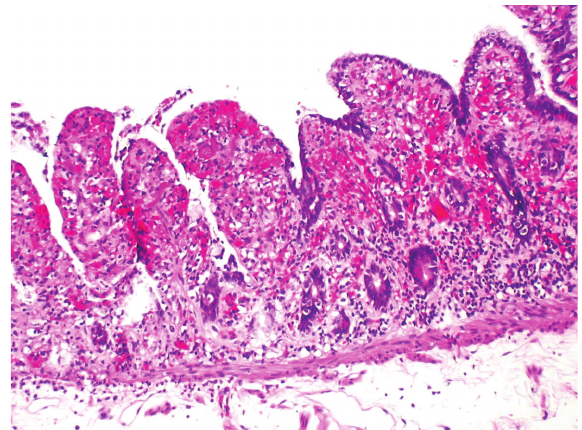
Figure 3: The histologic examination shows a haemorrhagic ischemic necrosis of the mucosa of the smaller intestine with a transmural congestion (corresponding to segment III in the other figures). Only 5mm of vital mucosa was left next to the cut margin.